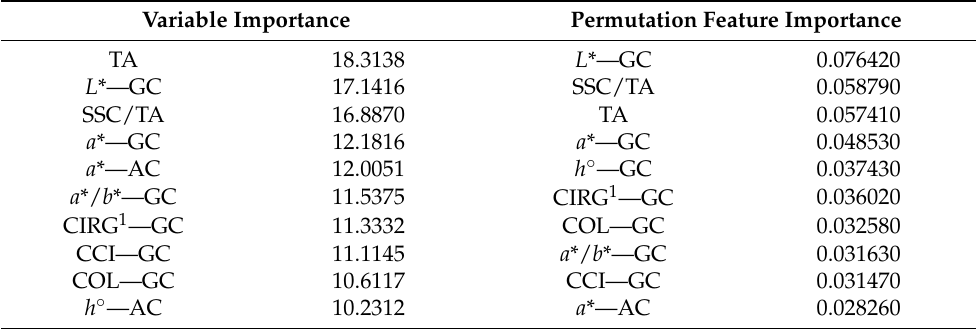
Table 2. Top 10 most contributing variables in the SMOTE balanced Model A dataset.